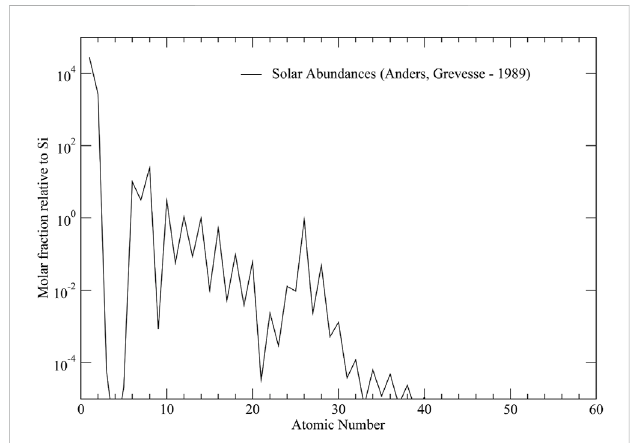
FIGURE 1 ThesolarabundancesfromdatatabulatedinRef.[1].The enhanced stability exhibited by α -cluster nuclei in imprinted directly onto the abundance